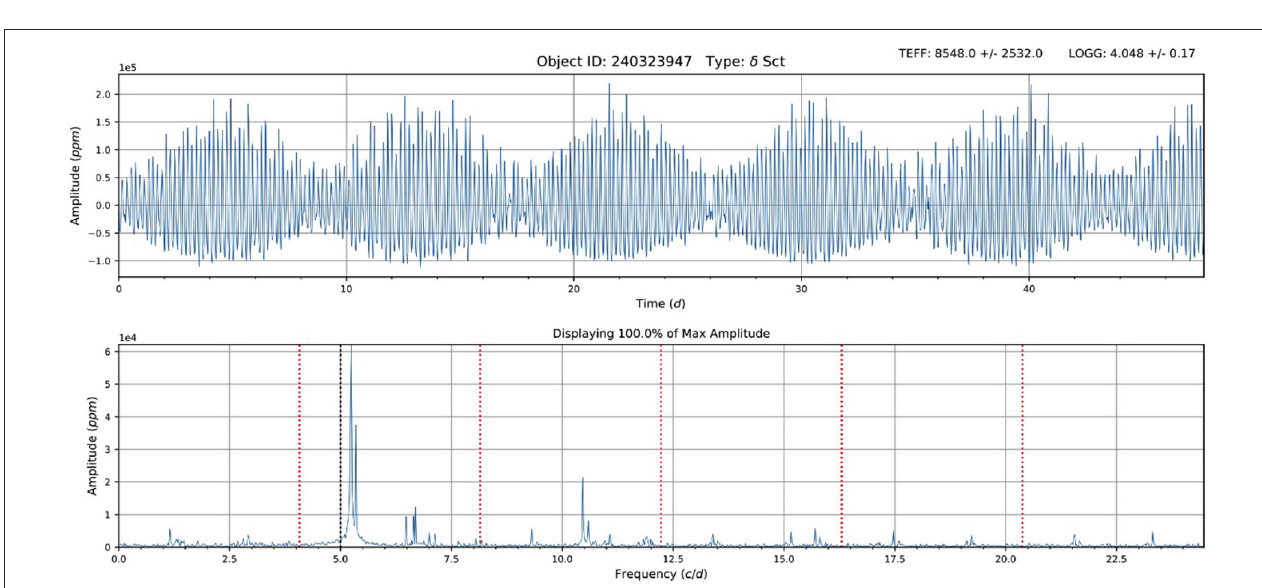
FIGURE 6 | Light curve (Top) and amplitude spectrum (Bottom) for known high-amplitude δ Sct star, EPIC 240323947 (V974 Oph), observed during